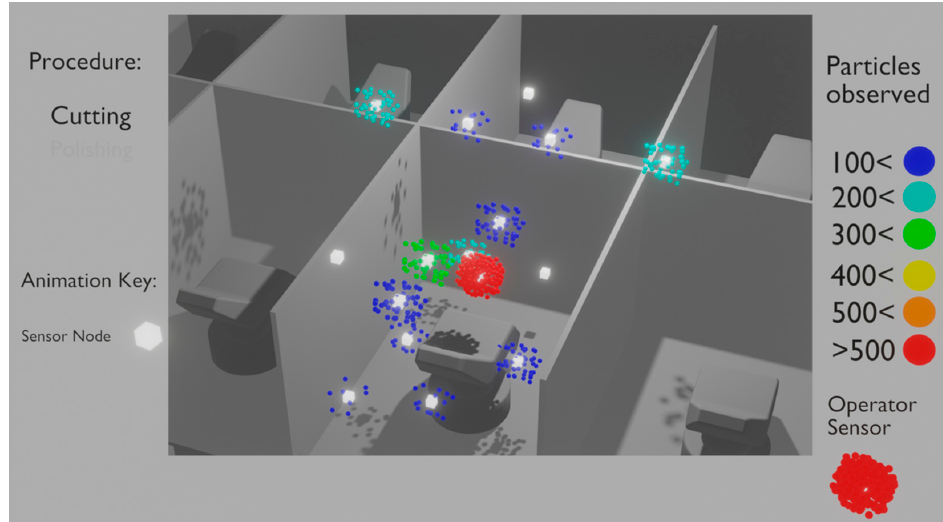
Figure 10. Real-time 3D visualization of the dental operatory D8 during a drilling procedure. Due to its importance, the operator’s device is highlighted in the bottom-right corner of the screen. While the aerosol concentration is at a safe level inside the cubicle, the physician is being exposed to a very high concentration of aerosols. Please see Supplementary Materials.